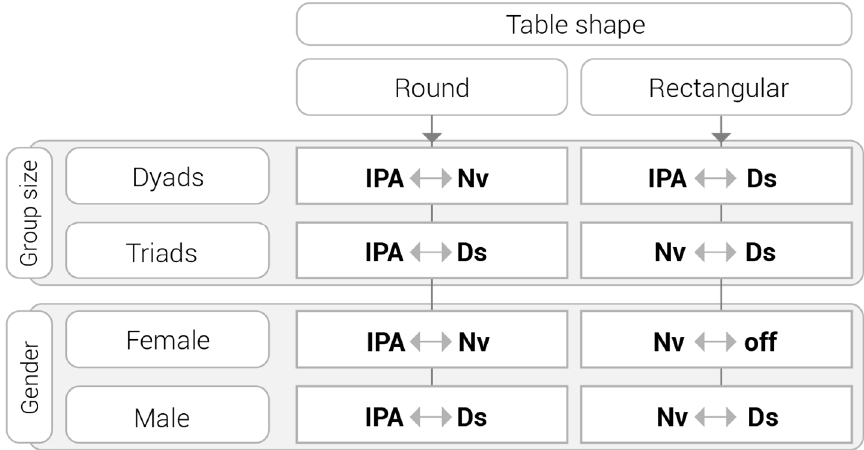
Figure 7. Summary of the epistemic network analysis (ENA) results of more prevalent co-occur- rences of on-task actions for each case